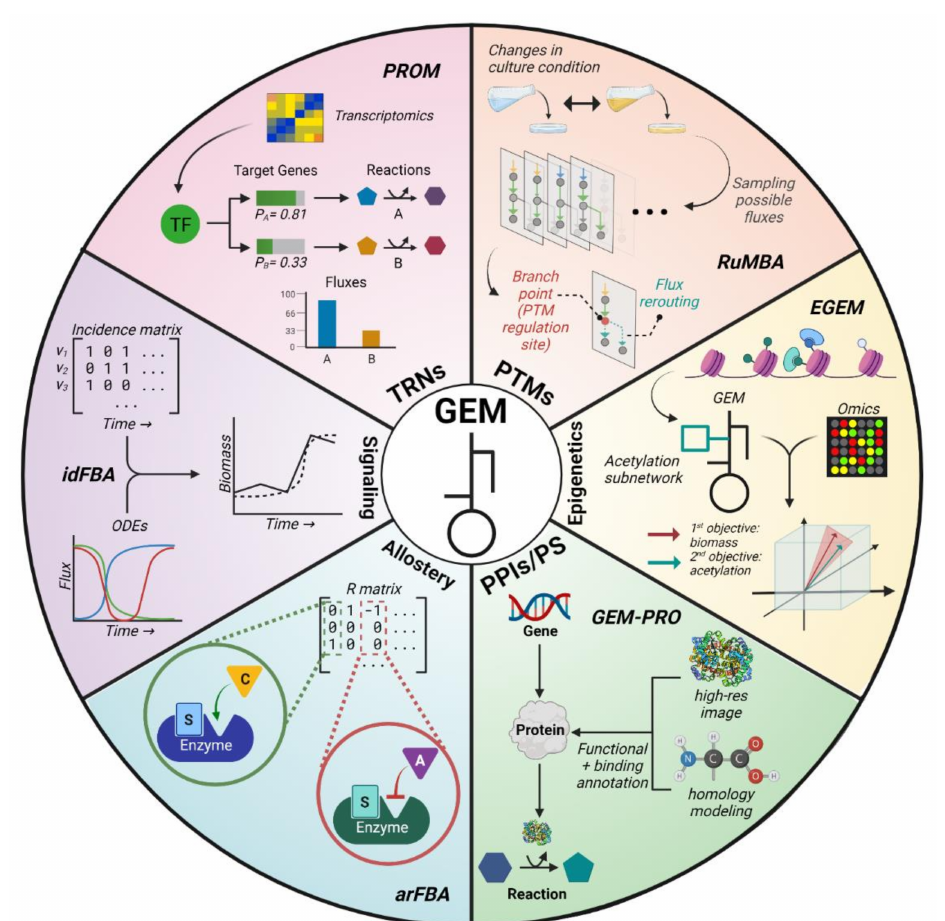
Figure 3. Representative algorithms (bolded) integrating regulatory mechanisms into genome-scale metabolic models (GEMs). PROM : probabilistic regulation of metabolism , uses transcriptomics and TF–gene networks to continuously restrict gene expression levels and then reaction fluxes [28]; RuMBA : regulated metabolic branch analysis , analyzes how fluxes change under different culture conditions to identify PTM regulatory sites [36]; EGEM : epigenome-scale metabolic network model , added a histone acetylation subnetwork to the human GEM and modified the objective function to maximize acetylation as well as biomass [39]; GEM-PRO : genome-scale models with protein structure , adds protein structural information into GEMs to capture how protein stability influences metabolic activity [41]; arFBA : allosteric regulation flux balance analysis , introduces a regulation (R) matrix that models the allosteric regulation of reactions in GEMs [43]; idFBA : integrated dynamic flux balance analysis , uses ODEs and an incidence matrix to model reaction fluxes dynamically